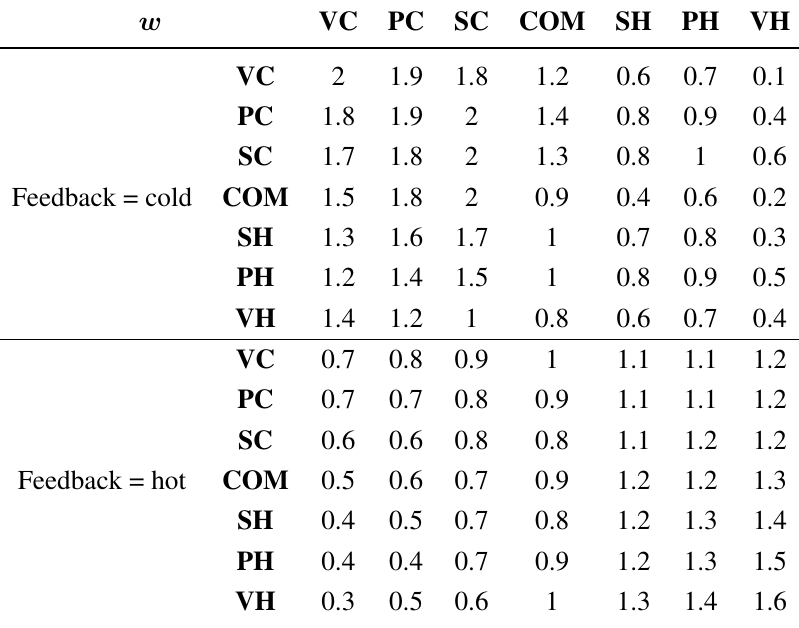
Table 10. Variation of the w parameter for the winter scenario.